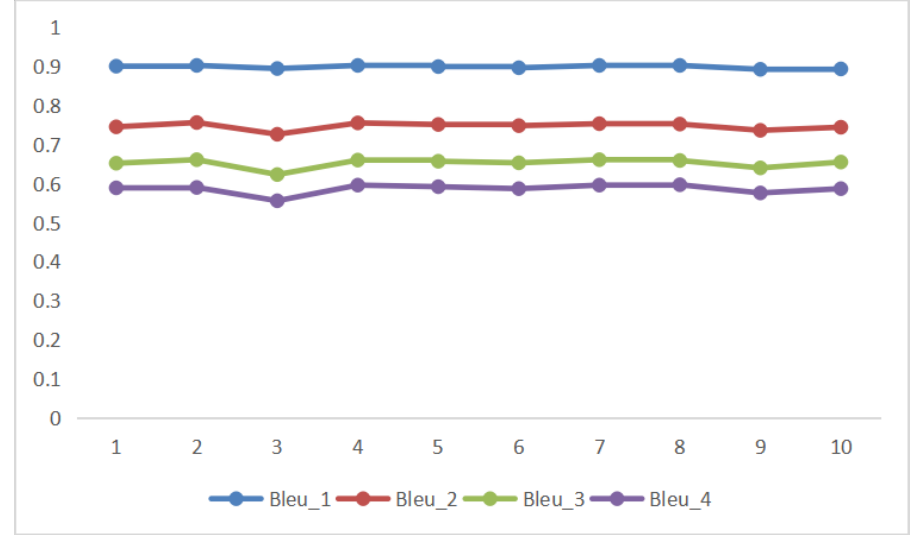
Figure 11. Bleu trend of ten experiments. It shows the trend of Bleu. From the figure, we can see that in ten experiments, the variation amplitudes of Bleu_1, Bleu_2, Bleu_3, and Bleu_4 are small, which can prove the randomness of data distribution and the robustness of the algorithm.